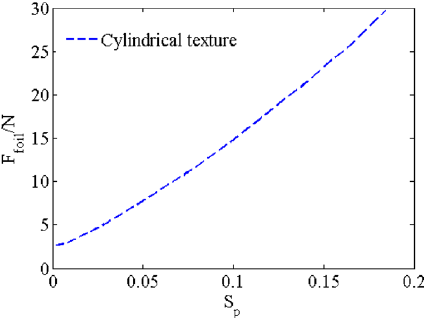
Figure 12. Effect of the area ratio S p of cylindrical texture on friction forces.